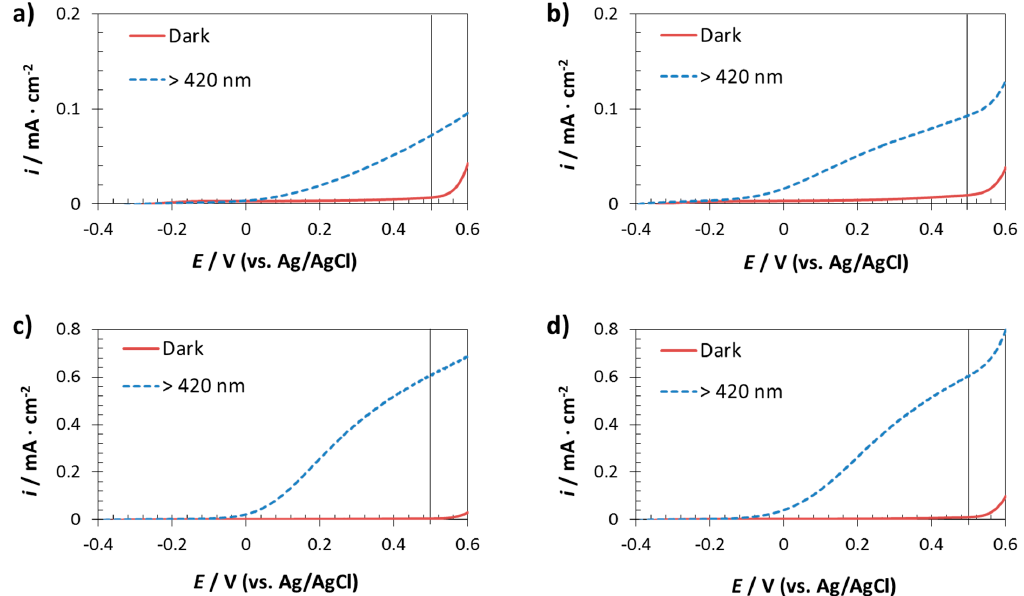
Figure 6. Current/photocurrent density versus applied potential curves of the photoanodes fabricated on Ti substrates: compact layer ( a ) and using different AAO templates: φ 90 nm ( b ), φ 260 nm ( c ) and φ 400 nm ( d ). Dark and visible light ( λ > 420 nm).